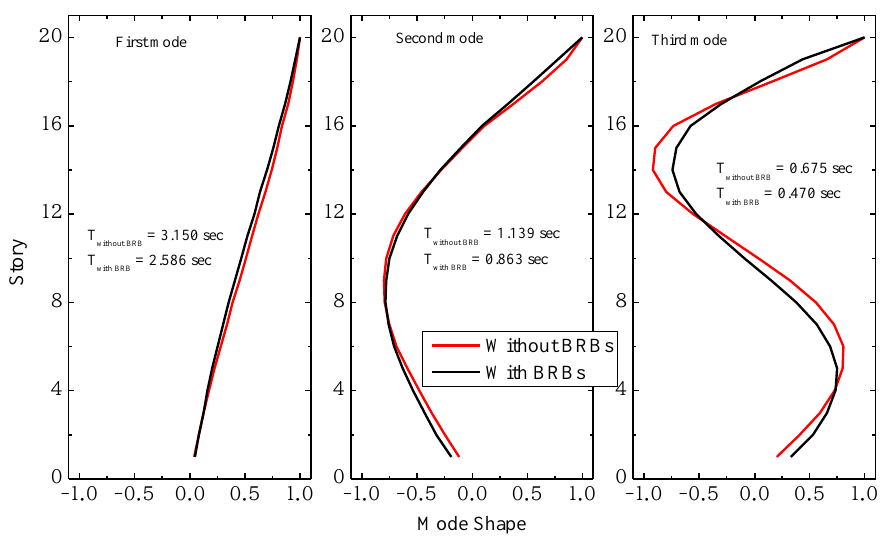
Figure 5. Normalized mode shape of the target high-rise building with and without BRBs devices.